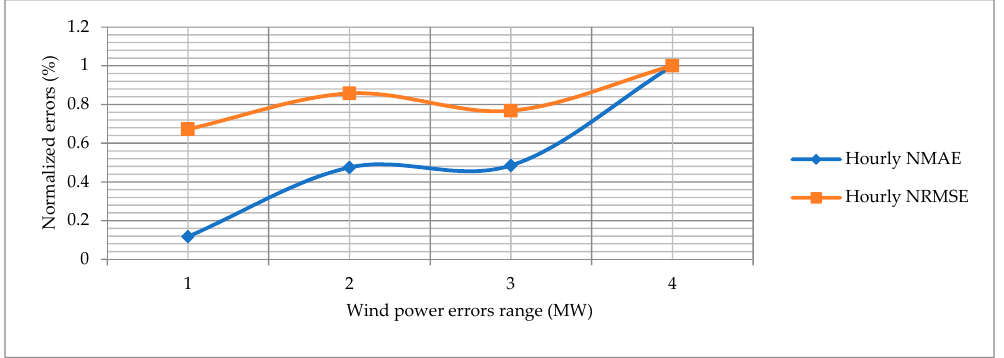
Figure 18. Normalized errors for hourly wind power forecasting.